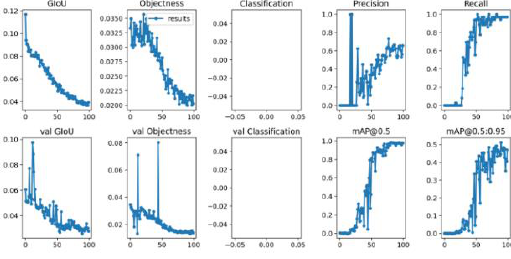
Fig. 5. Accuracy of detection model while training